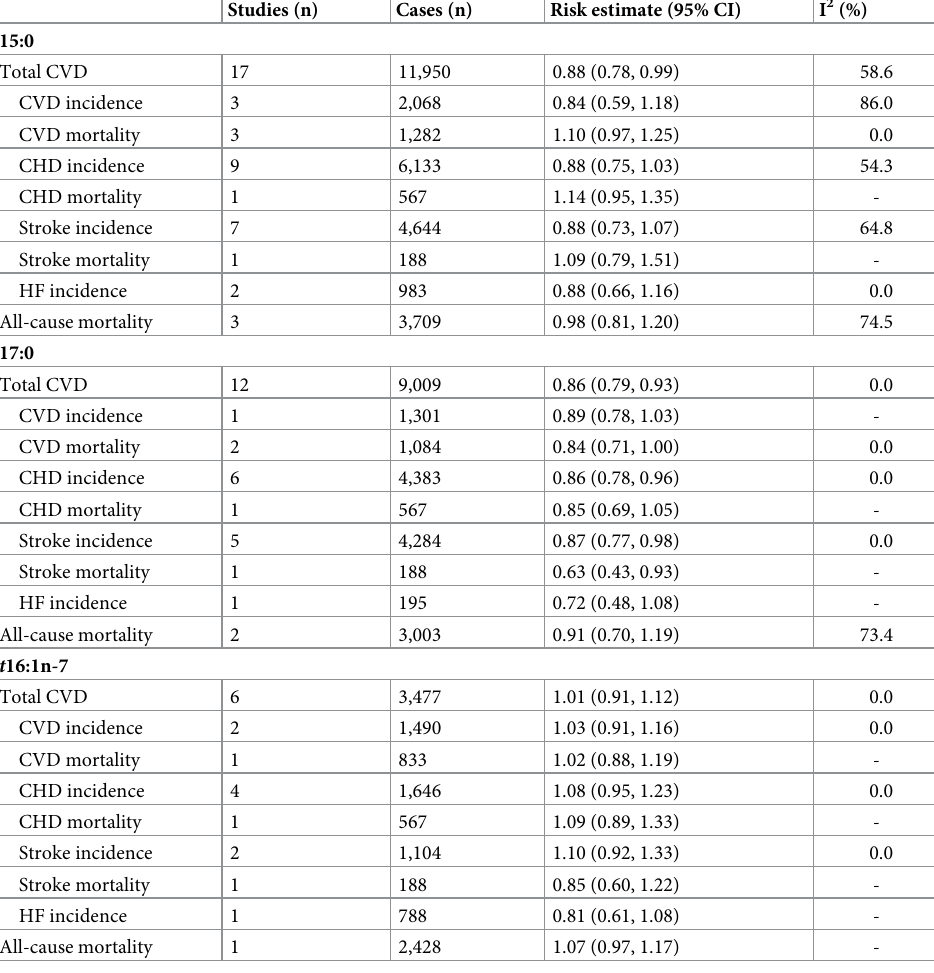
Table 4. Pooled risk estimates of CVD subtypes and all-cause mortality in the top versus bottom tertiles of 15:0, 17:0, and t 16:1n-7 1